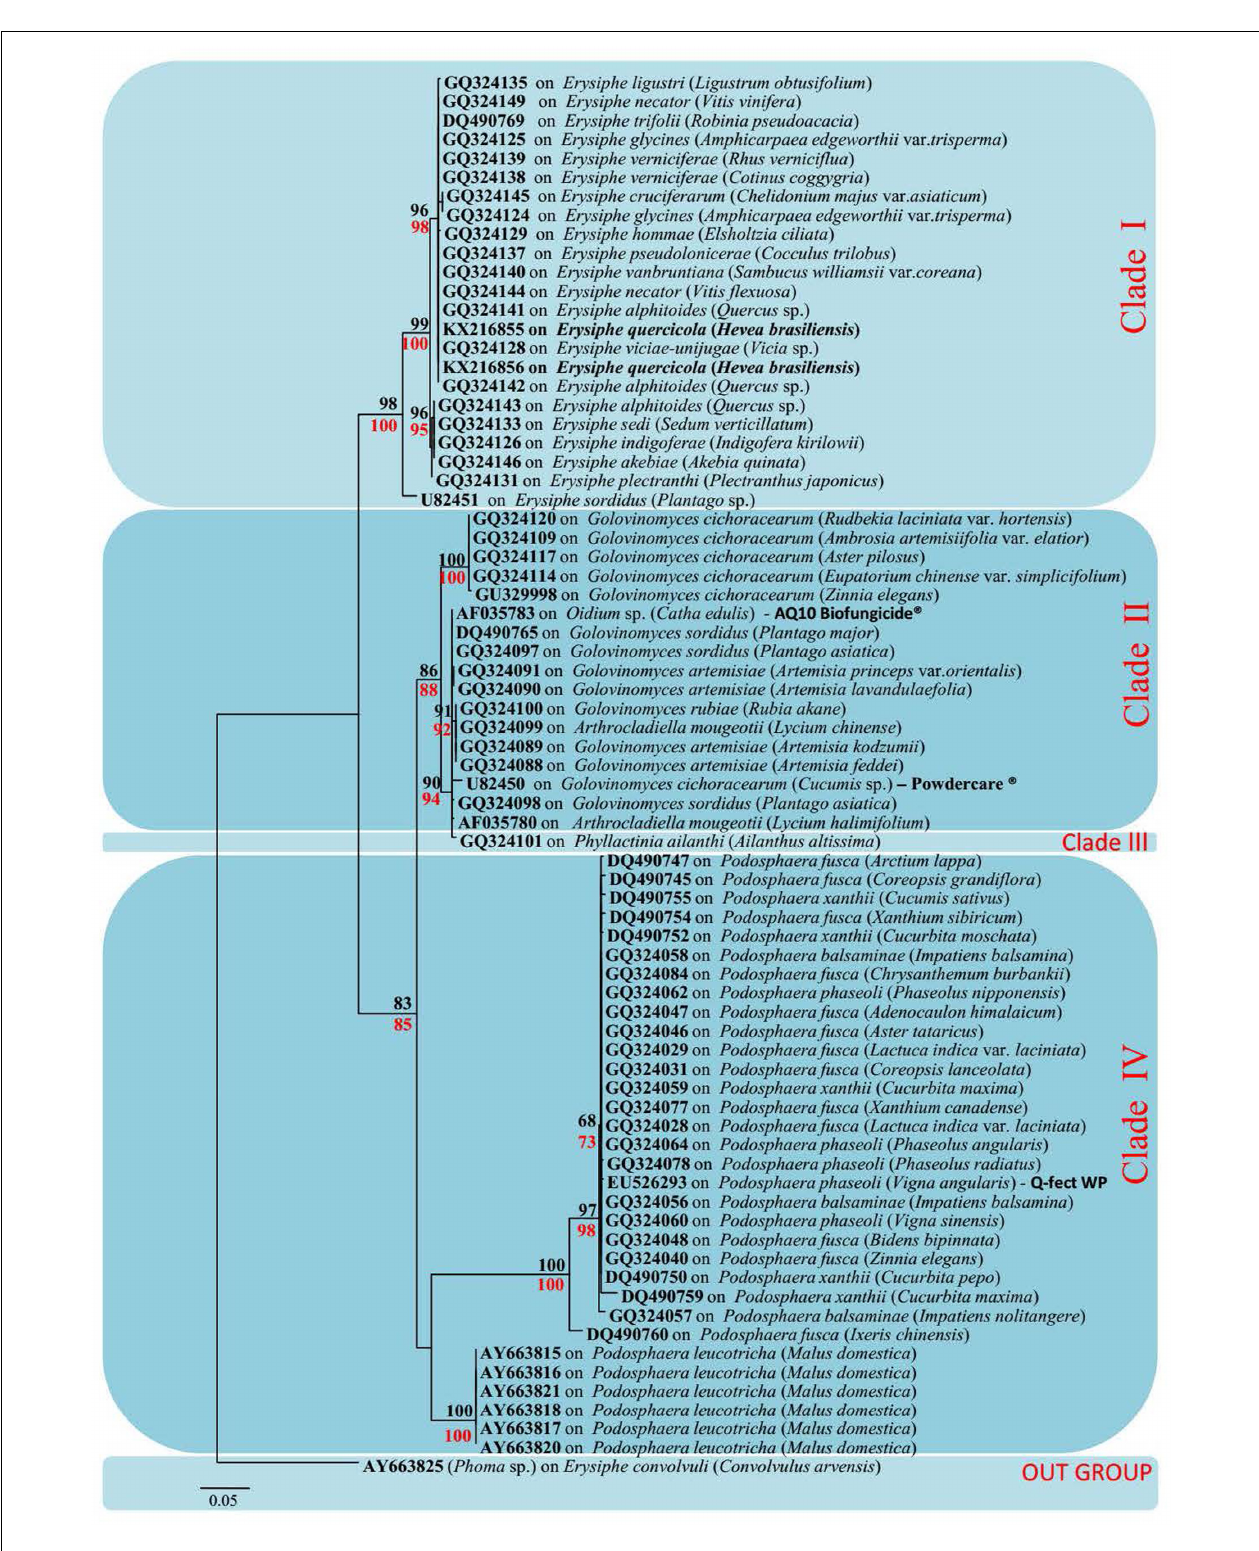
FIGURE 3 | Maximum-likelihood (ML) tree based on a dataset of ITS sequences. Bootstrap support (BS) values for (ML, black) and maximum parsimony (MP, red) higher than 60% are defined as above the nodes. The tree is rooted to Phoma sp. (All mycohost species associated with Ampelomyces spp. are listed along with the GenBank accession number. The host plant for different mycohosts is presented in brackets. Sequences generated from this study are presented in bold text).